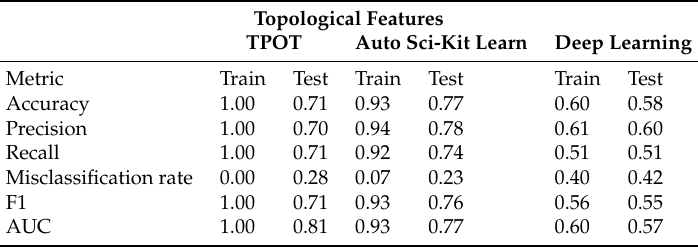
Table 3. Machine Learning Accuracy—Textural Features.